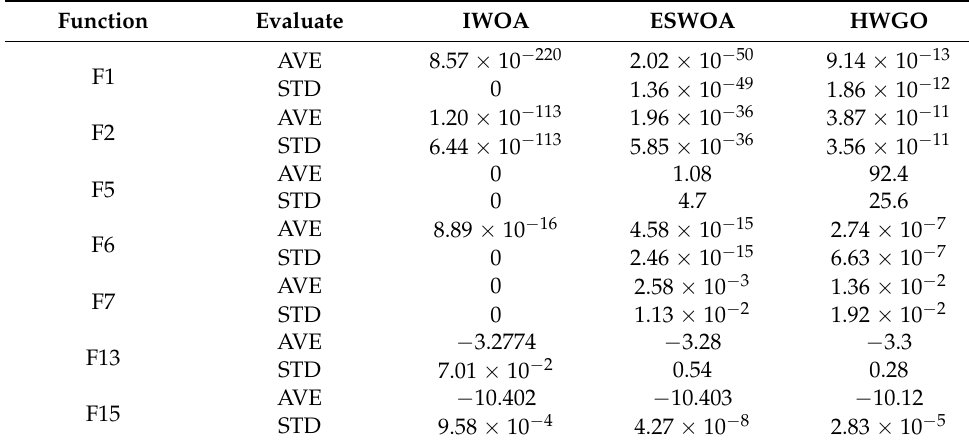
Table 6. Performance comparison between IWOA and other improved WOA.